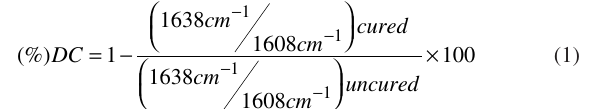
Table 1. Averages of microhardness and standard deviation of the Filtek Z250 TM material. Photo-activation time (seconds)